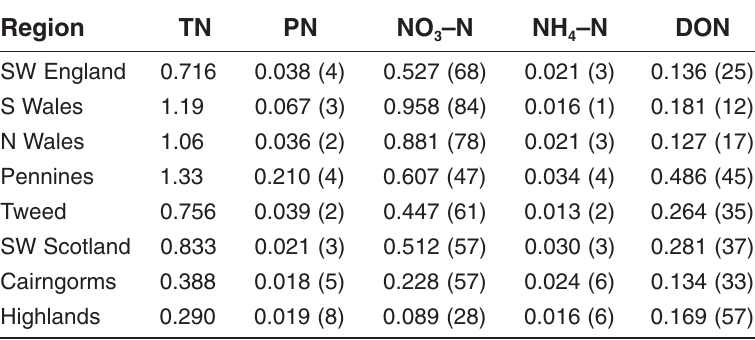
The Annual Flow-Weighted Mean Concentration (mg l –1